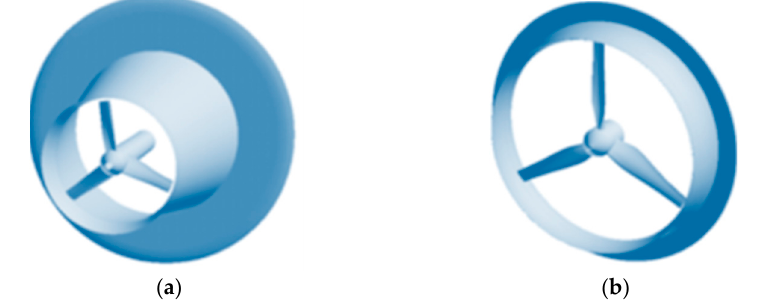
Figure 2. Representative shapes of WLTs: ( a ) Prototype; ( b ) Compact type.